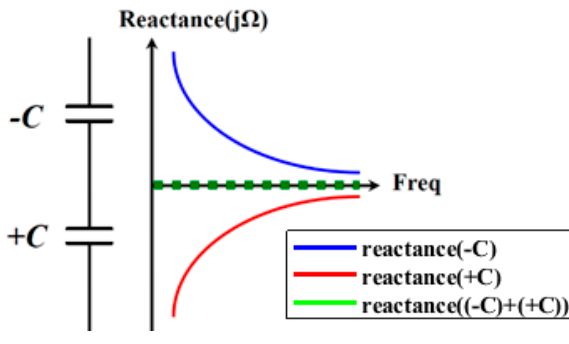
Figure 1. Foster impedance matching.